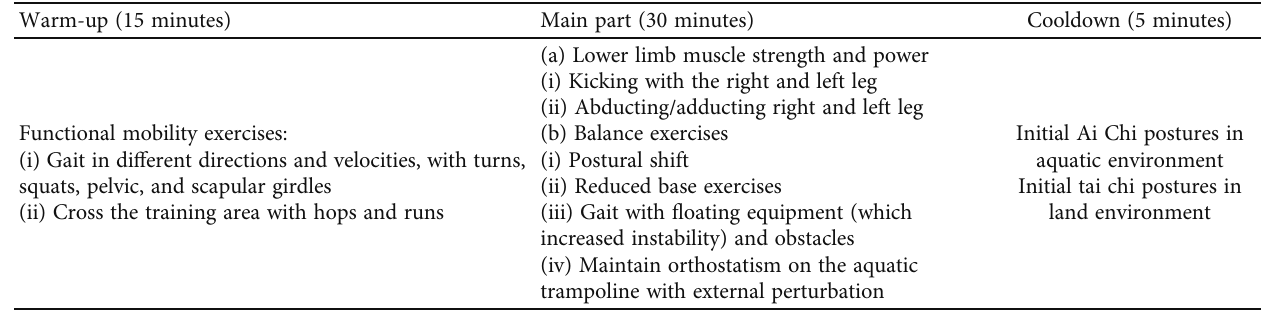
Figure 1: Overview of assessments and interventions. BBS: Berg balance scale; Mini-BEST: mini-balance evaluation system test; UPDRS: uni fi ed Parkinson ’ s disease rating scale; II: activities of daily living; III: motor aspects; DGI: dynamic gait index; QS: quiet stand; AS: assessment; AI: aquatic intervention; LI: land-based intervention. Table 1: Multimodal intervention program framework.